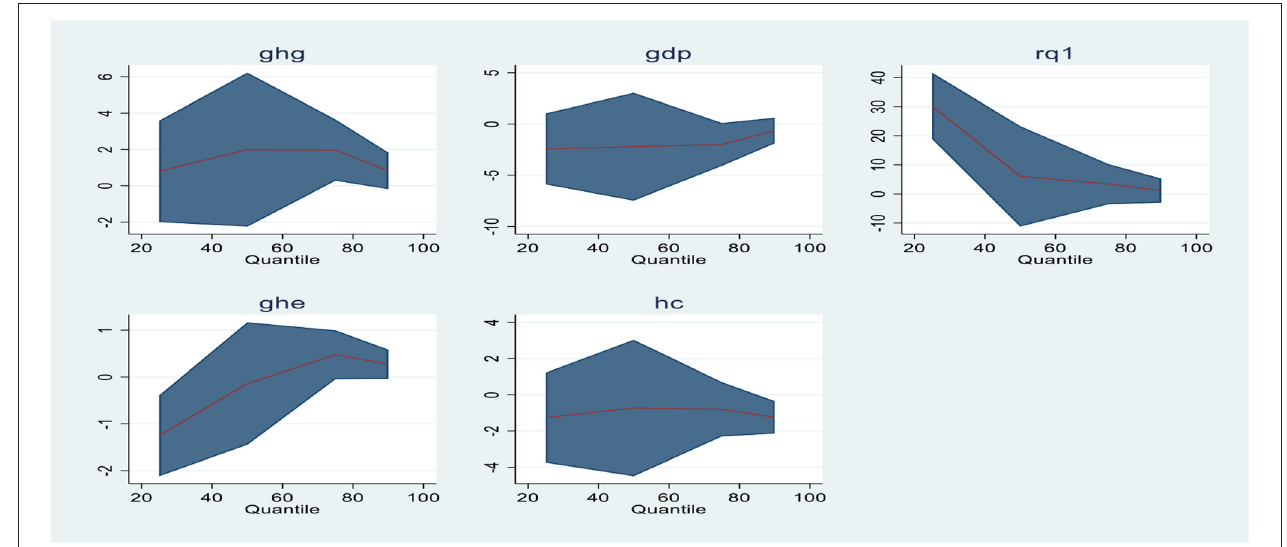
FIGURE 1 | Graphical representation of quantiles for Model